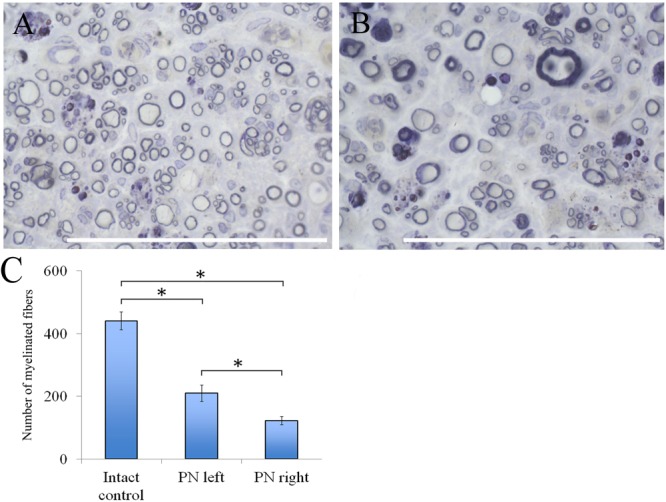
Myelin fibers of the distal segment of the sciatic nerve. (A) Myelin fibers of the distal segment of the left sciatic nerve, (B) Myelin fibers of the distal segment of the right sciatic nerve. Top: histological staining with osmium and methylene blue. Bar: 50 μm. (C) Number of myelinated fibers: 440.67 ± 29.06 (Intact, n = 6), 210.17 ± 26.55 (PN left, n = 5), 122.17 ± 12.61 (PN right, n = 5). Bottom: quantification of myelin fibers of the sciatic nerve. Error bars represent standard error mean. Differences were statistically significant between the groups (∗), (∗P < 0.05, one-way ANOVA, Tukey’s test).